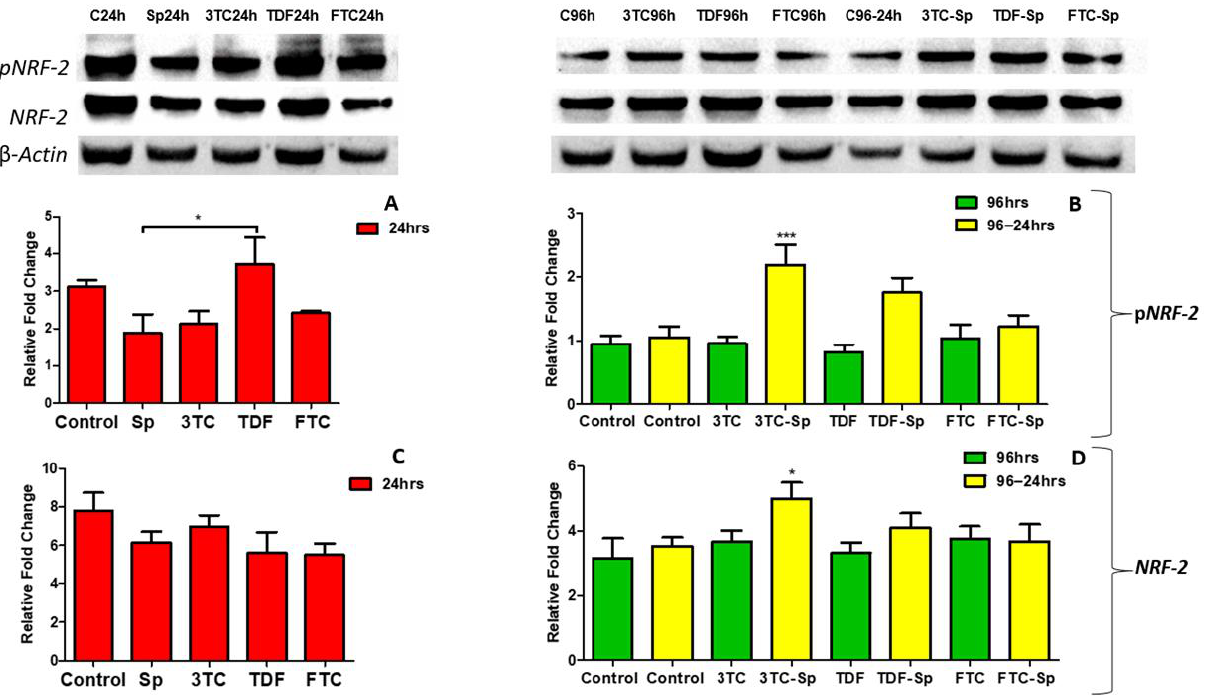
Figure 8. Effects of SP and HAART (3TC, TDF, and FTC) on pNRF-2 and NRF-2 protein expression. pNRF-2 protein expression after exposure of HepG2 cells to ( A ): SP and HAART for 24 h, ( B ): HAART (96 h), and HAART (96 h) followed by SP (24 h); NRF-2 protein expression after exposure of HepG2 cells to ( C ): SP and HAART for 24 h, ( D ): HAART (96 h), and HAART (96 h) followed by SP (24 h); * p < 0.05, *** p < 0.0001 .